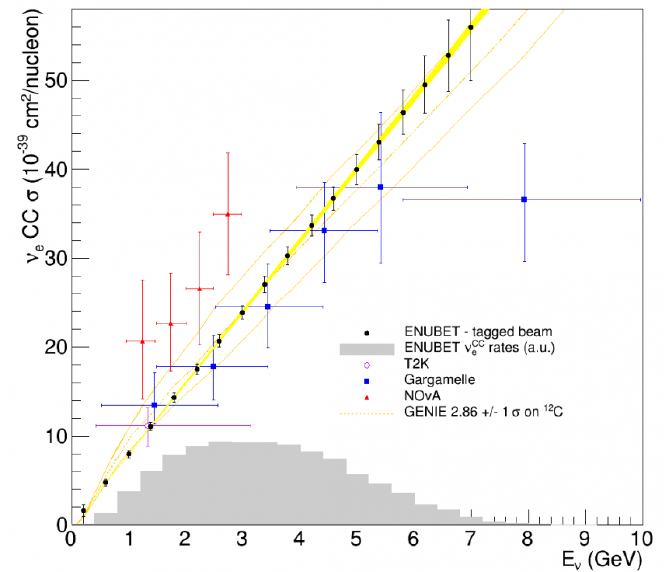
Figure 12. Impact of ENUBET on the knowledge of the ν e cross-section. The ENUBET measurement and the statistical errors are shown with black dots. The orange bands represent the current systematic uncertainty from GENIE. The yellow band is the ENUBET systematic uncertainty on the flux. Past measurements from Gargamelle, T2K and NO ν Aare also shown. The gray area shows the ν e CC energy spectrum of